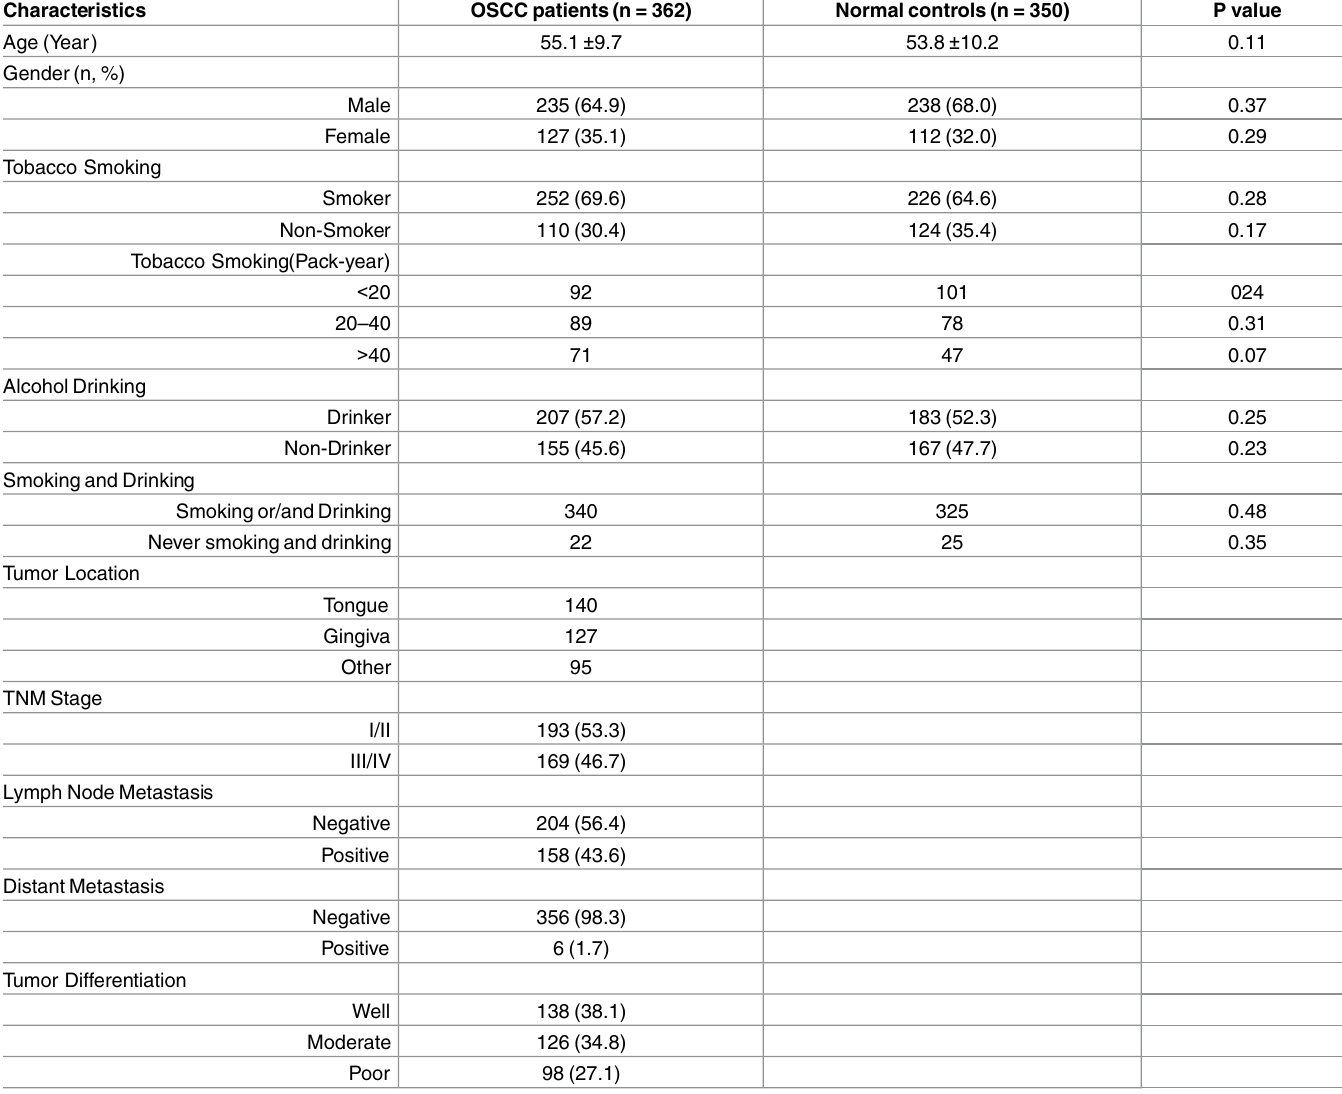
Table 1. Clinicalcharacteristicsof OSCC patientsand